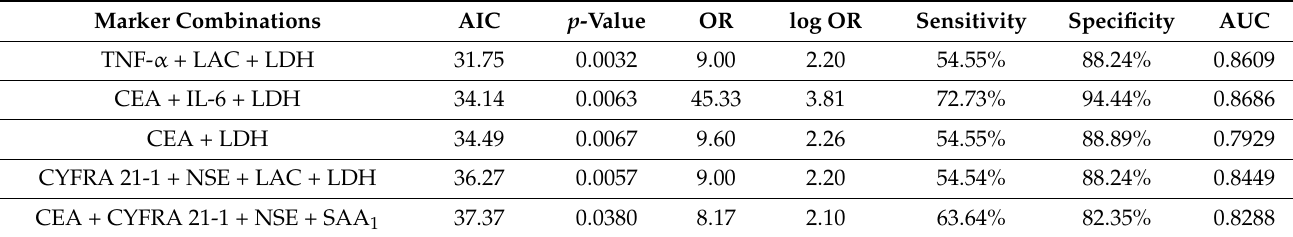
Table 12. The diagnostic efficiency of multi-biomarker models to distinguish stage IIIA NSCLC patients from stage IIB NSCLC